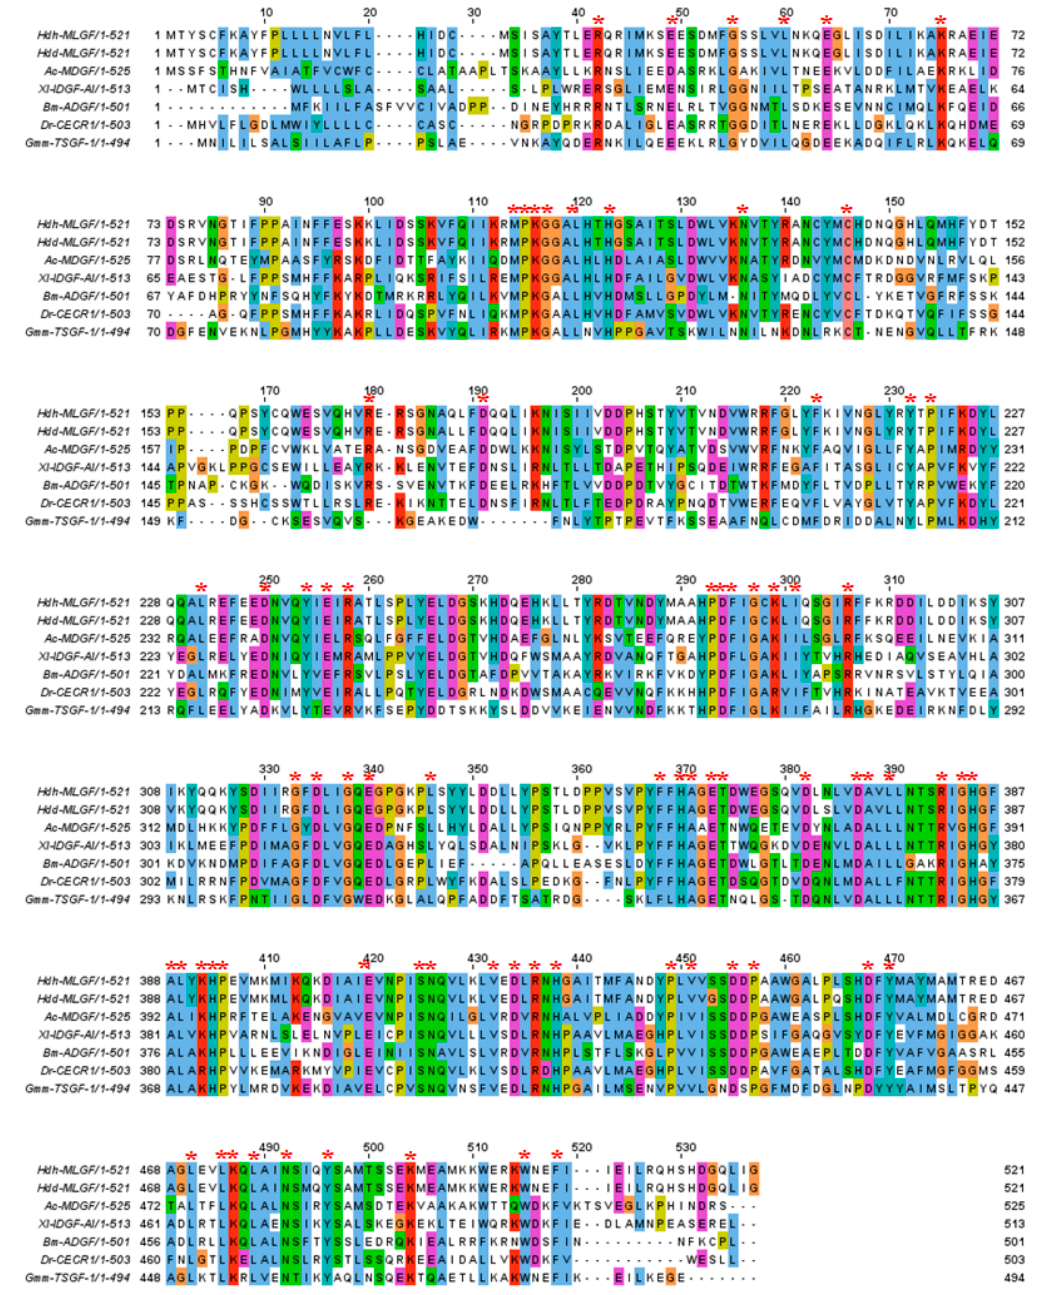
Figure 3. Multiple sequence alignments of mollusk-like growth factor from the deduced amino acid sequences of H. discus hannai (accession no. ON803449), H. discus (ABO26607.1), Aplysia californica (AAD13112.1), Xenopus l aevis (AAY42596.1), Bombyx mori (BAF73622.1), Danio rerio (AAL40922.1),